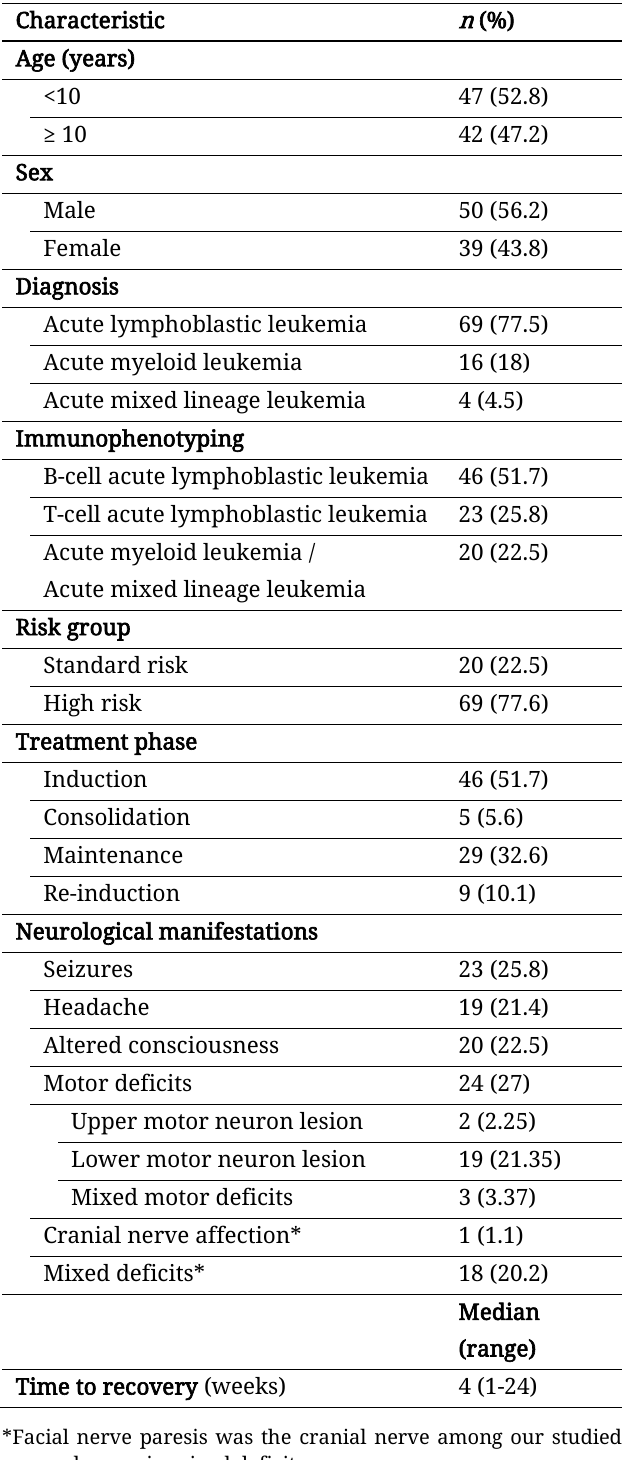
Table 1: Demographic and clinical characteristics